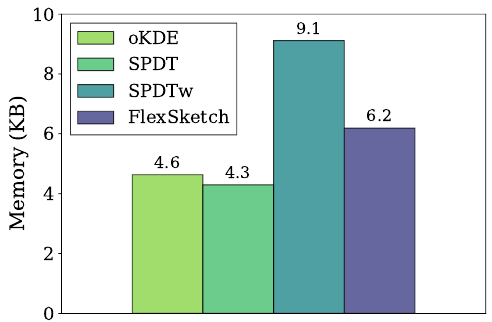
Figure 9. Comparison of memory